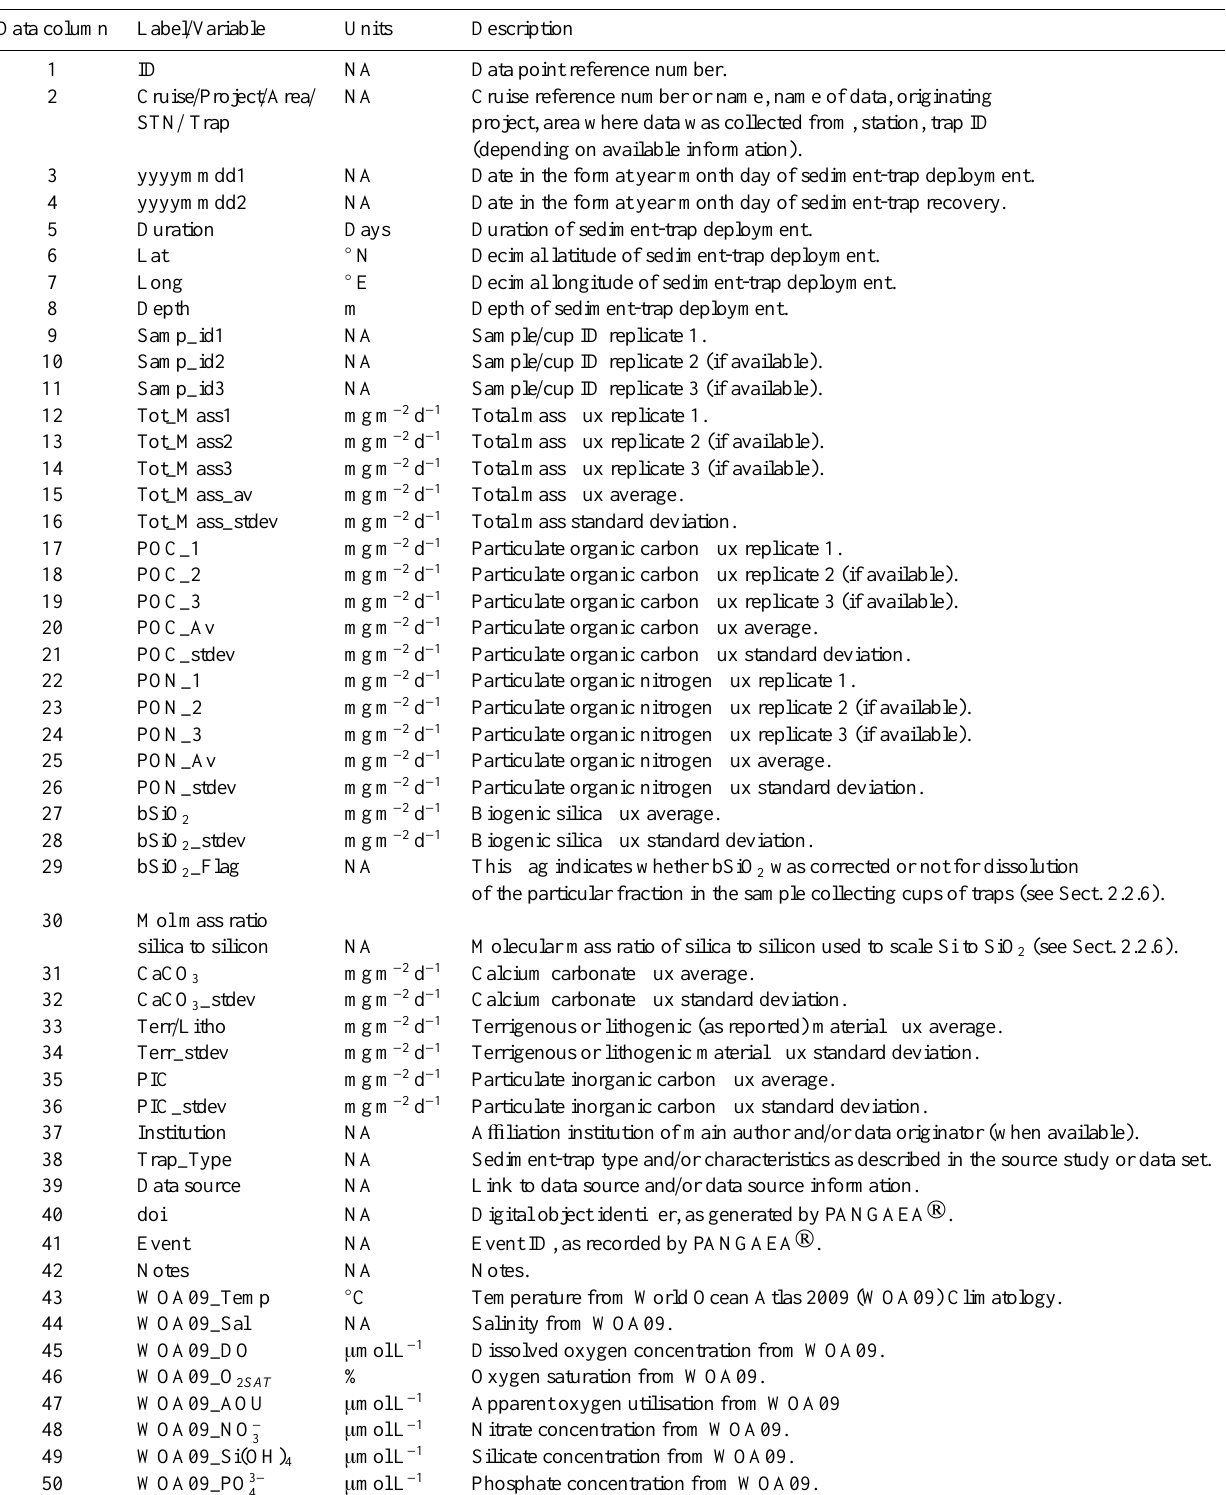
Table 1. Data set column headers. All fluxes are reported as per day over the period of deployment. We note that only at BATS are samples collected in triplicate. Hence, other than BATS, data under the “replicate 1” and “average” headers contain the same information. Not applicable is denoted